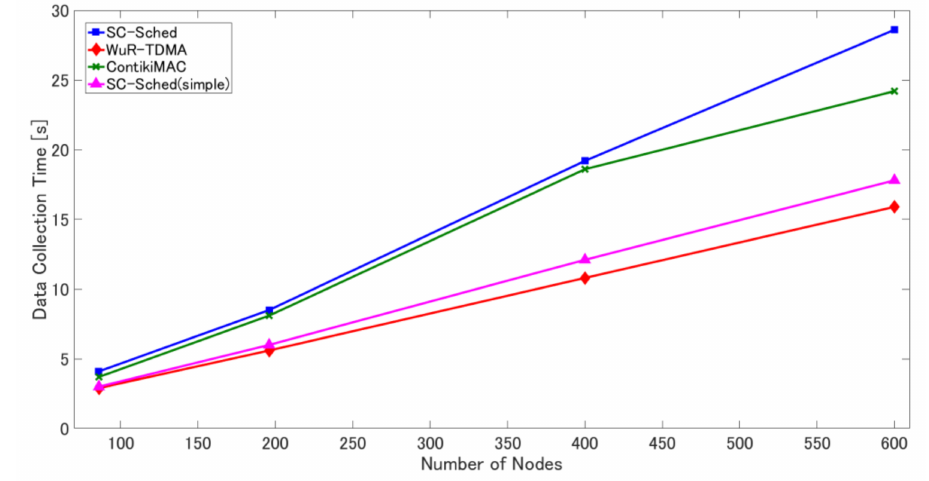
Figure 9. Data collection time in the four methods under different numbers of sensor